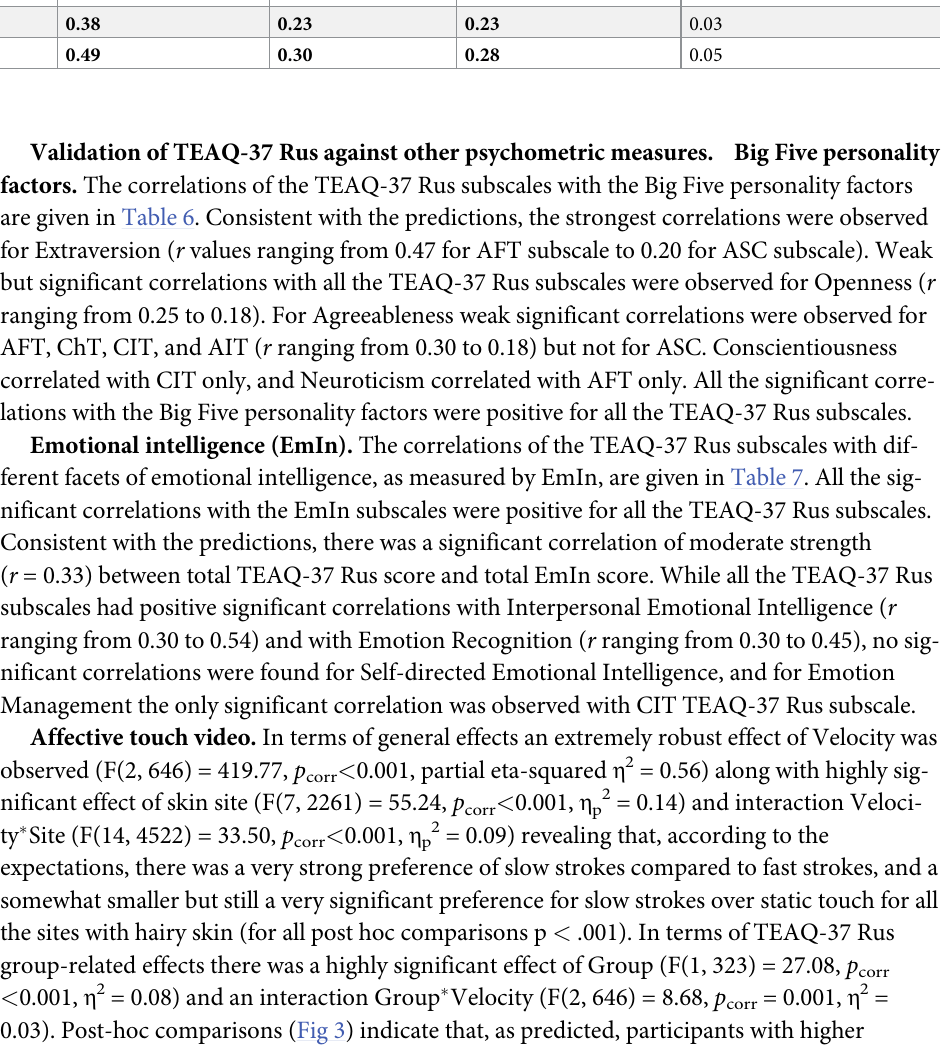
Table 7. Correlations of the TEAQ-37 Rus subscales with the EmIn subscales ( r values). Interpersonal